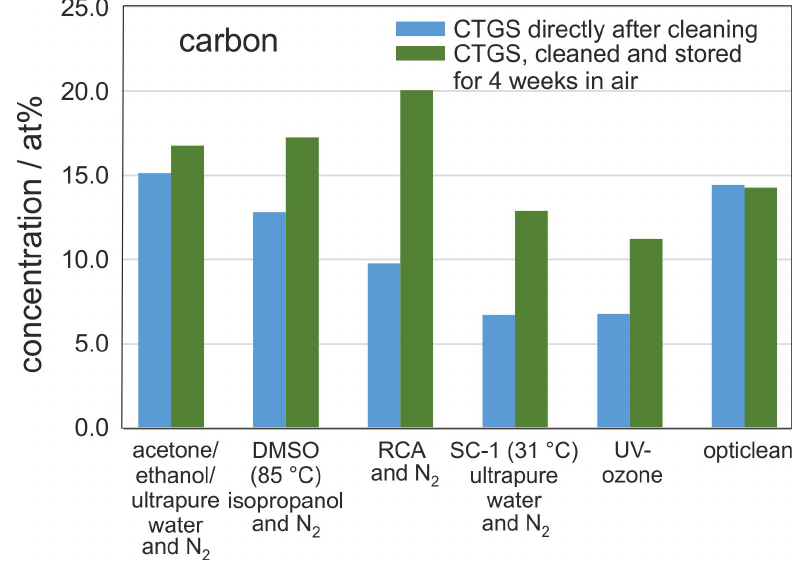
Figure 4. Carbon concentration on the CTGS surface measured for one set of samples directly after the respective cleaning procedure and after 4 weeks of storage under ambient air. Measured with XPS (Al source with neutralizer).